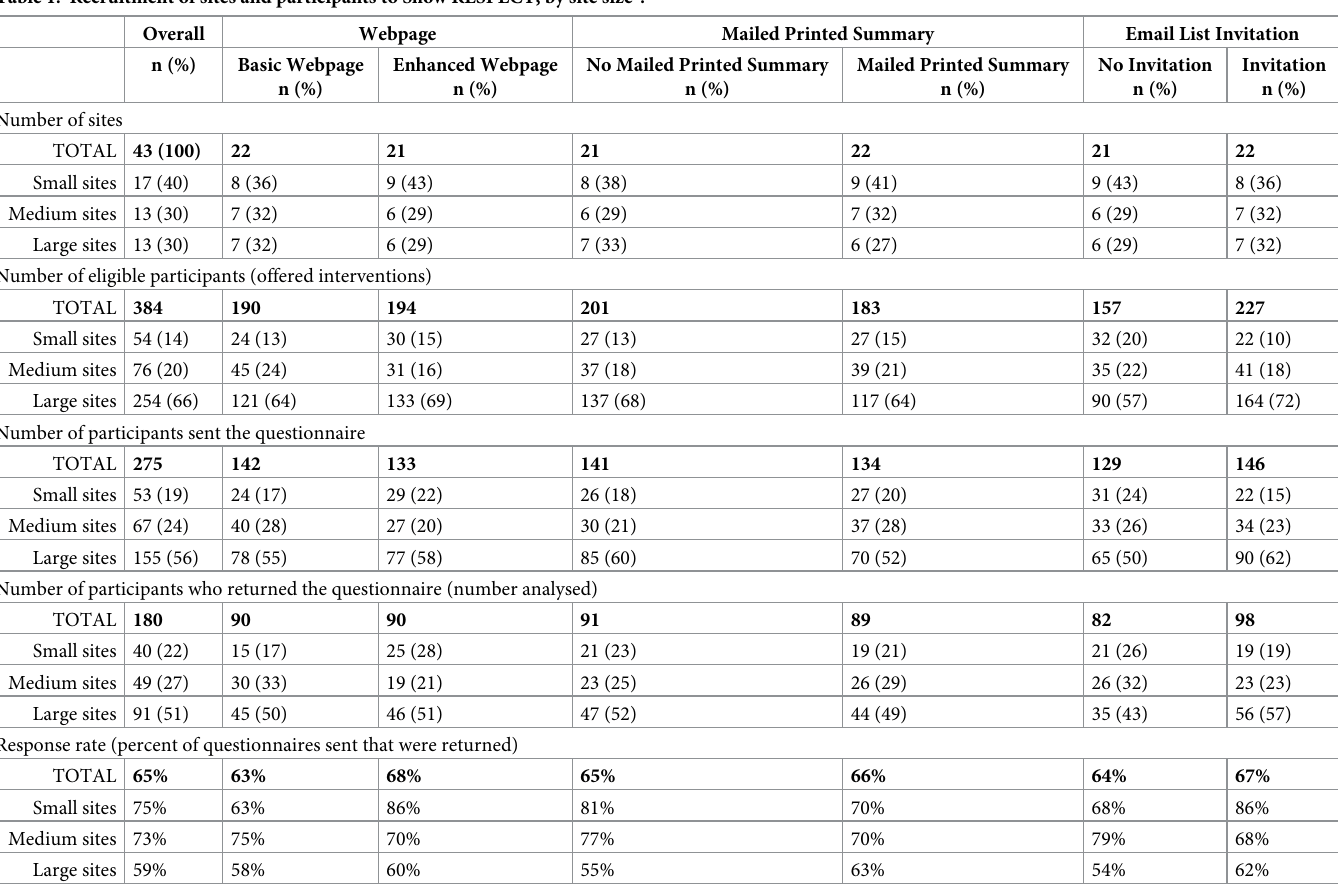
Table 1. Recruitment of sites and participants to Show RESPECT, by site size 1